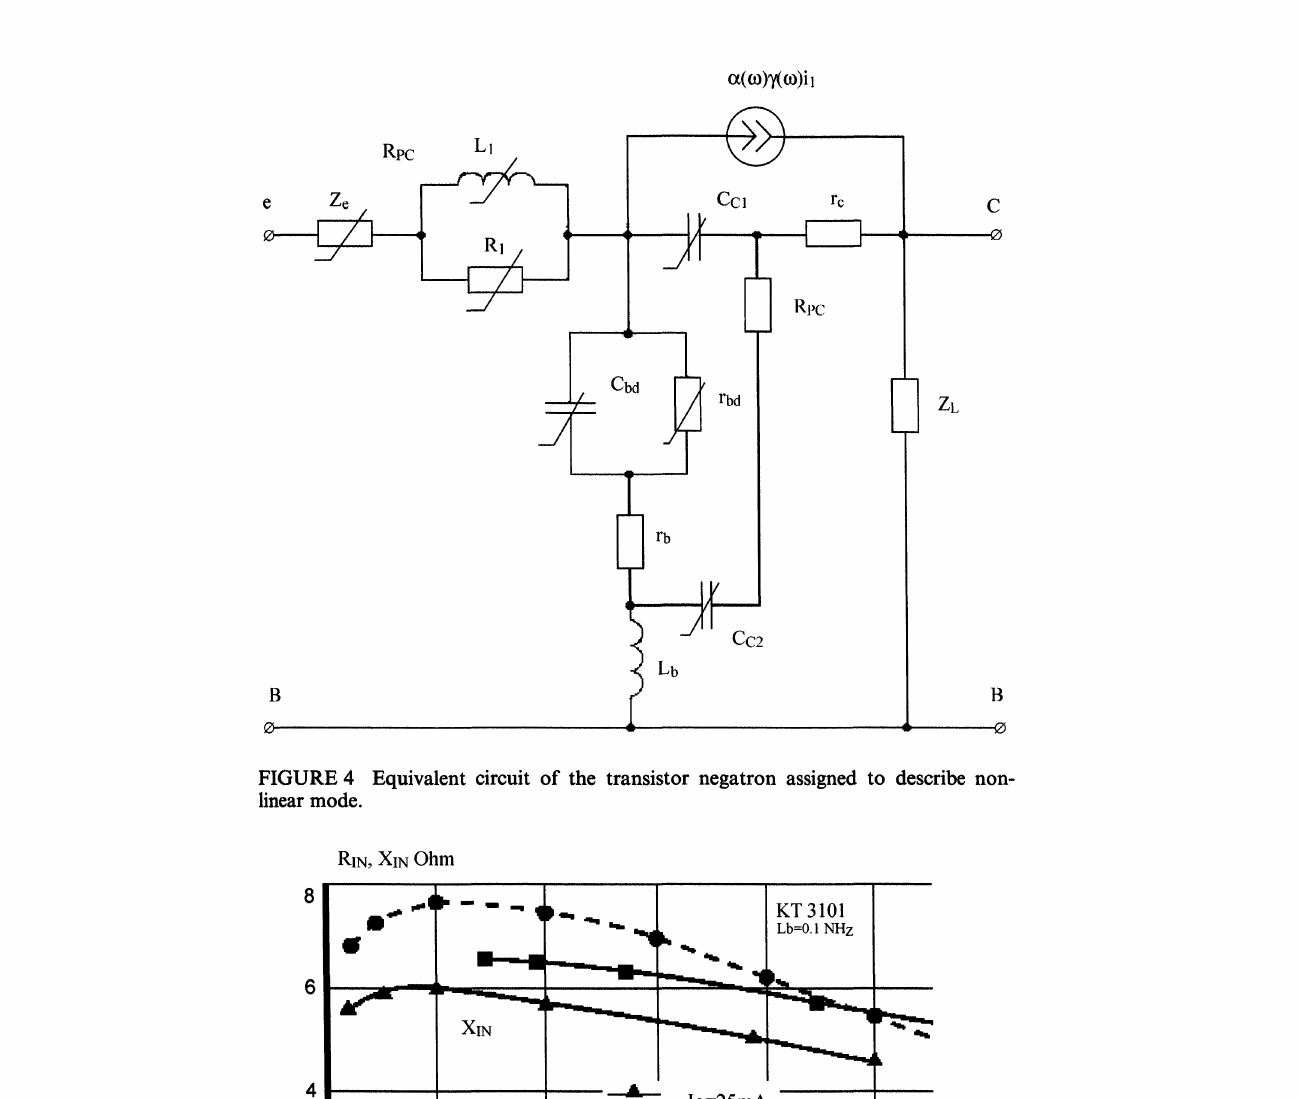
FIGURE 5 Components of impedance versus input power for different emitter currents